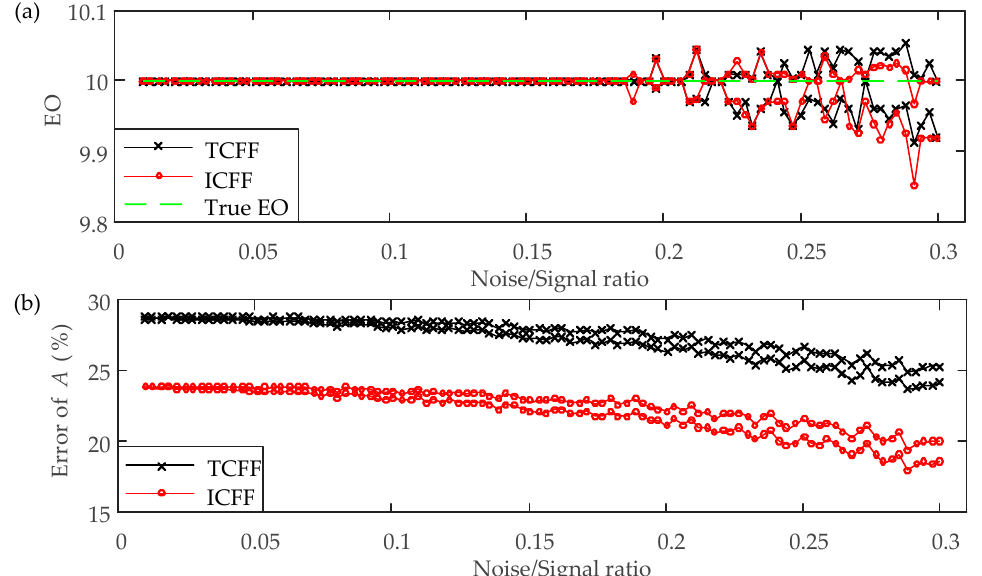
Figure 7. Results of Test 3. ( a ) 95% confidence intervals of the EO identification and ( b ) 95% confidence intervals of the relative error of the amplitude identification.